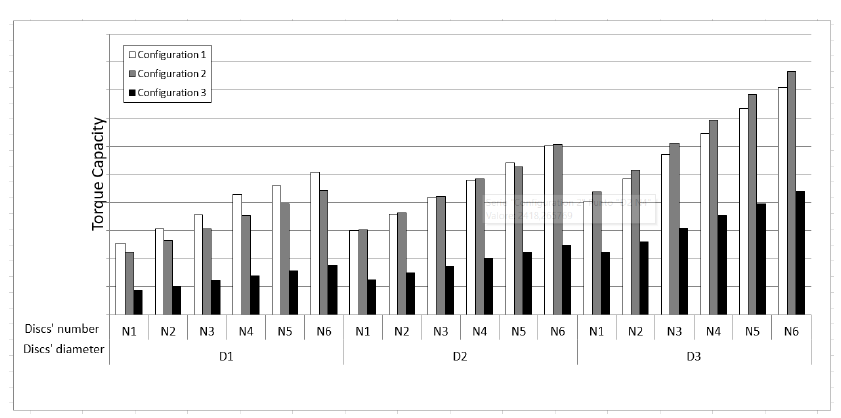
Figure 6. Torque capacity requirement addressed by the clutch DA.